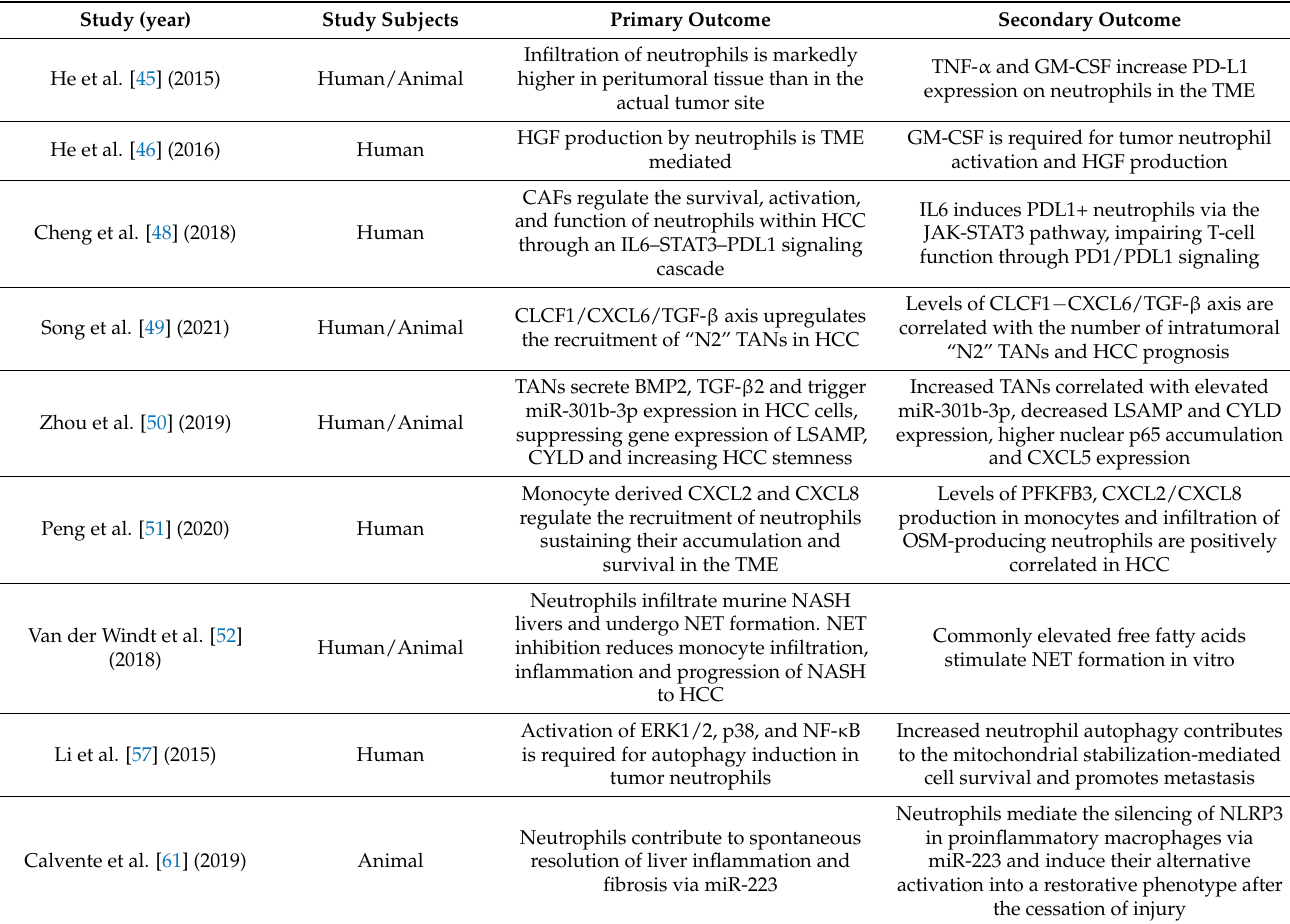
Table 1. Summary of studies evaluating the role of TANs in HCC